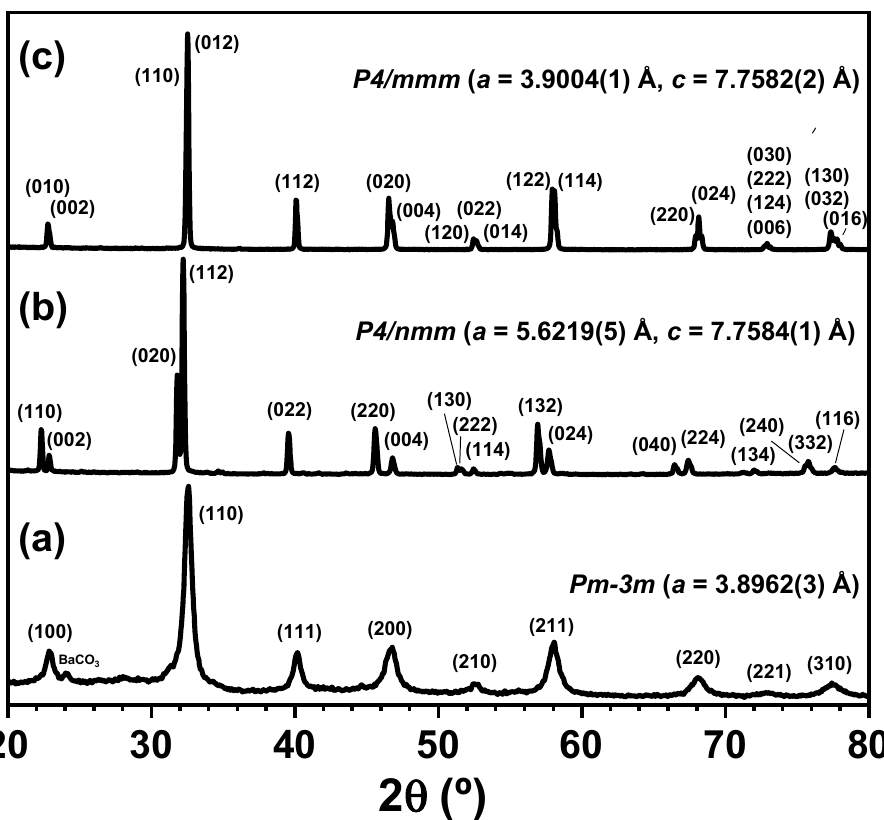
Figure 5. Room-temperature XRD patterns of ( a ) PBMO-m , ( b ) PBMO-m + 1100 °C/Ar and ( c ) PBMO-m + 1100 °C/Ar + TG/air samples.